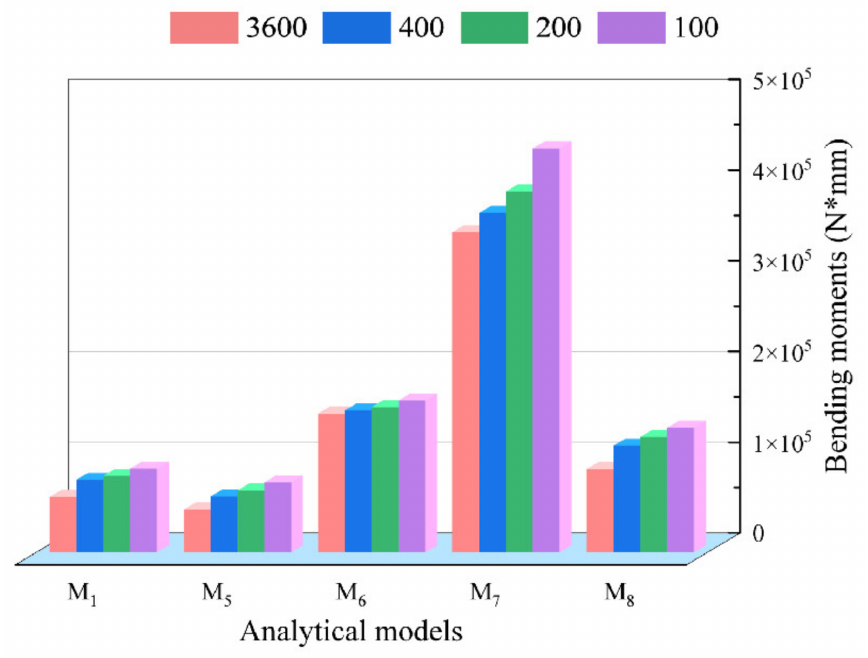
Figure 16. Specific calculation results of M 1 , M 5 , M 6 , M 7 , and M 8 . Table 4. Accuracy analysis of bending moments: M 1 , M 5 , M 6 , M 7 and M 8 (unit: